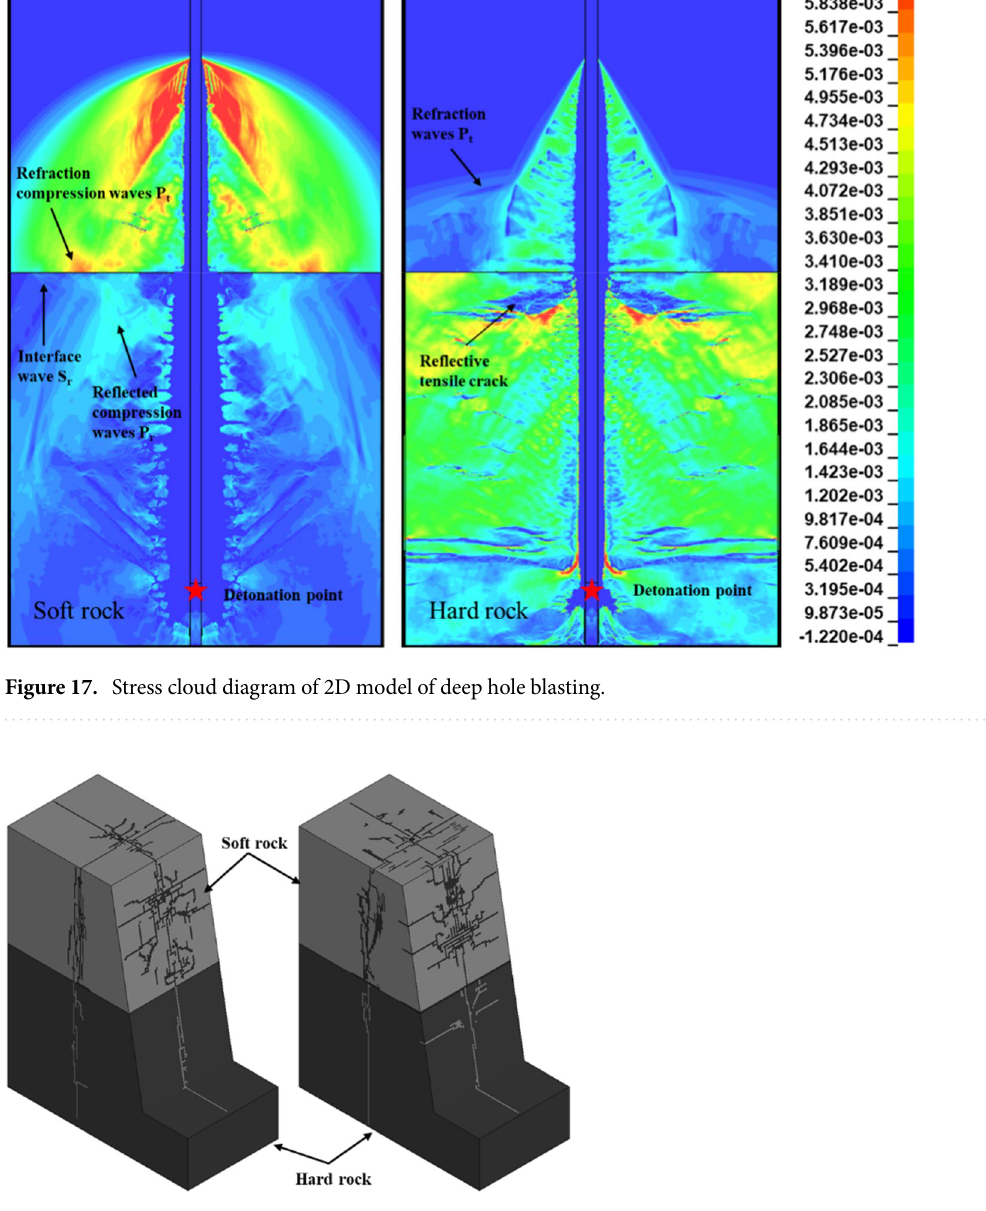
Figure 18. Development of step explosion